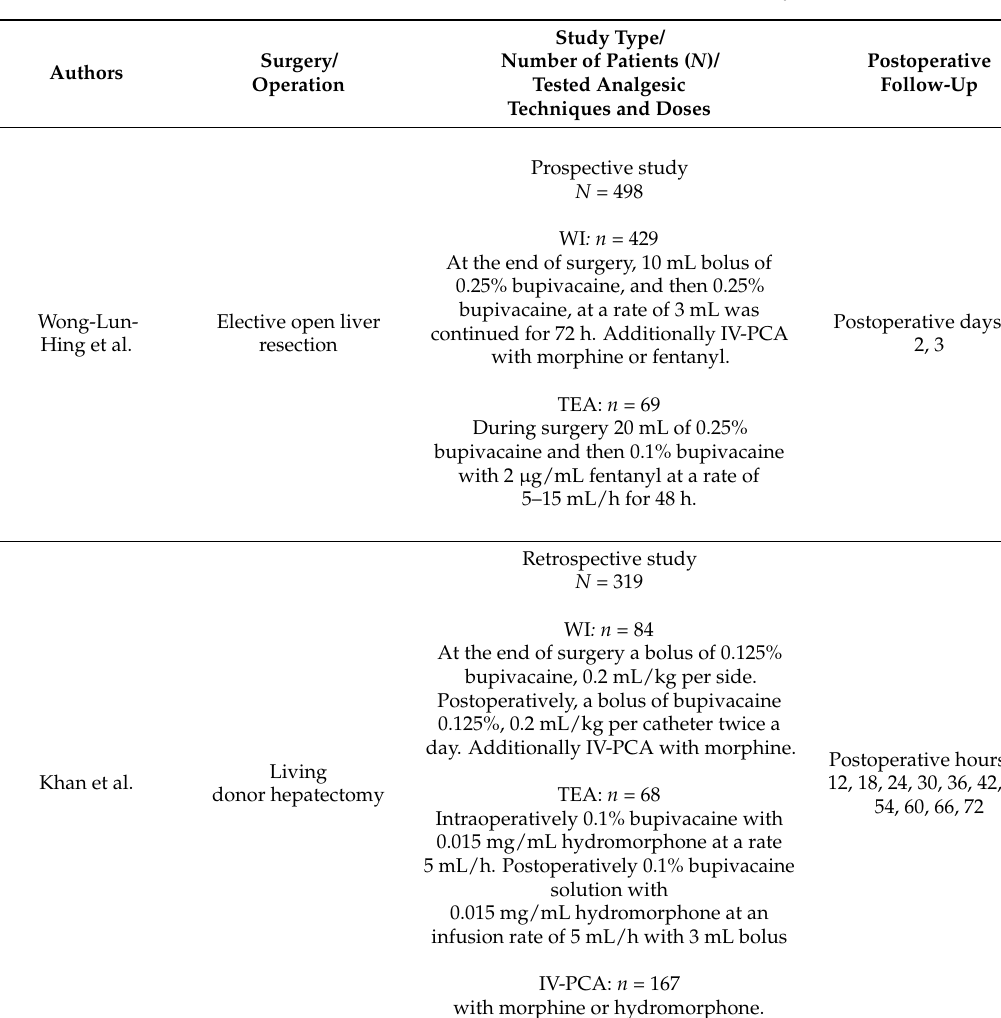
Table 3. Summary of the studies included in this systematic